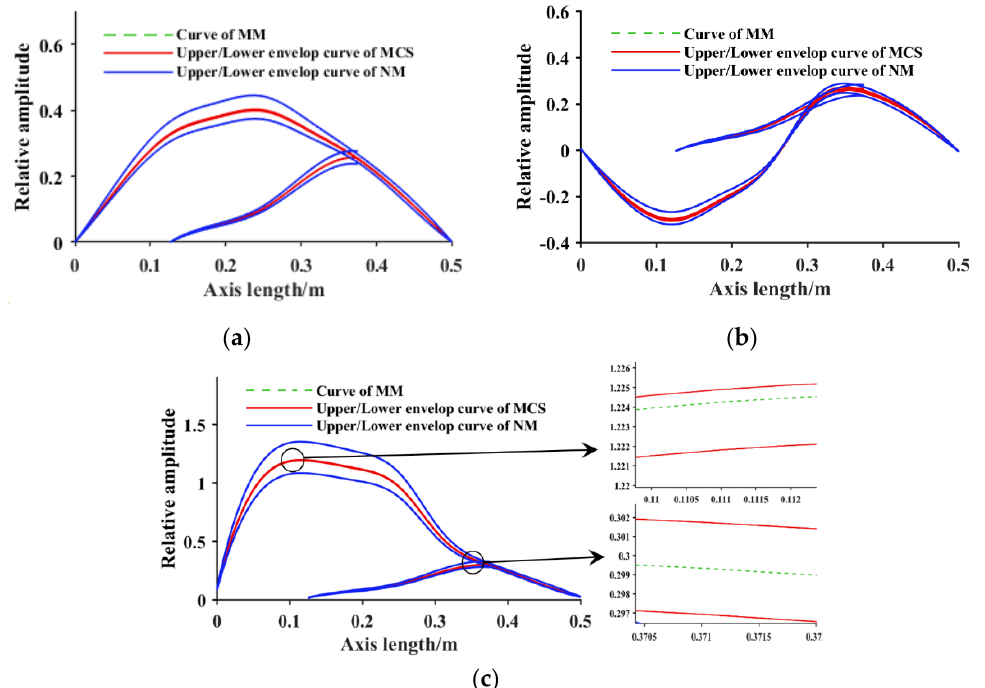
Figure 5. Upper and lower boundaries of the first three ‐ order vibration modes of two rotors for C ov , k = 0.20. ( a ) The first ‐ order vibration mode. ( b ) The second ‐ order vibration mode. ( c ) The third ‐ order vibration mode.